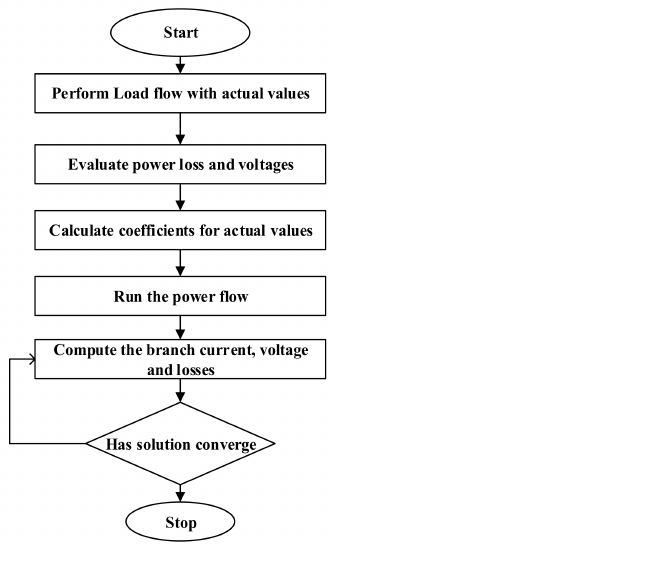
Figure 2. Flow chart for symmetry fuzzy load